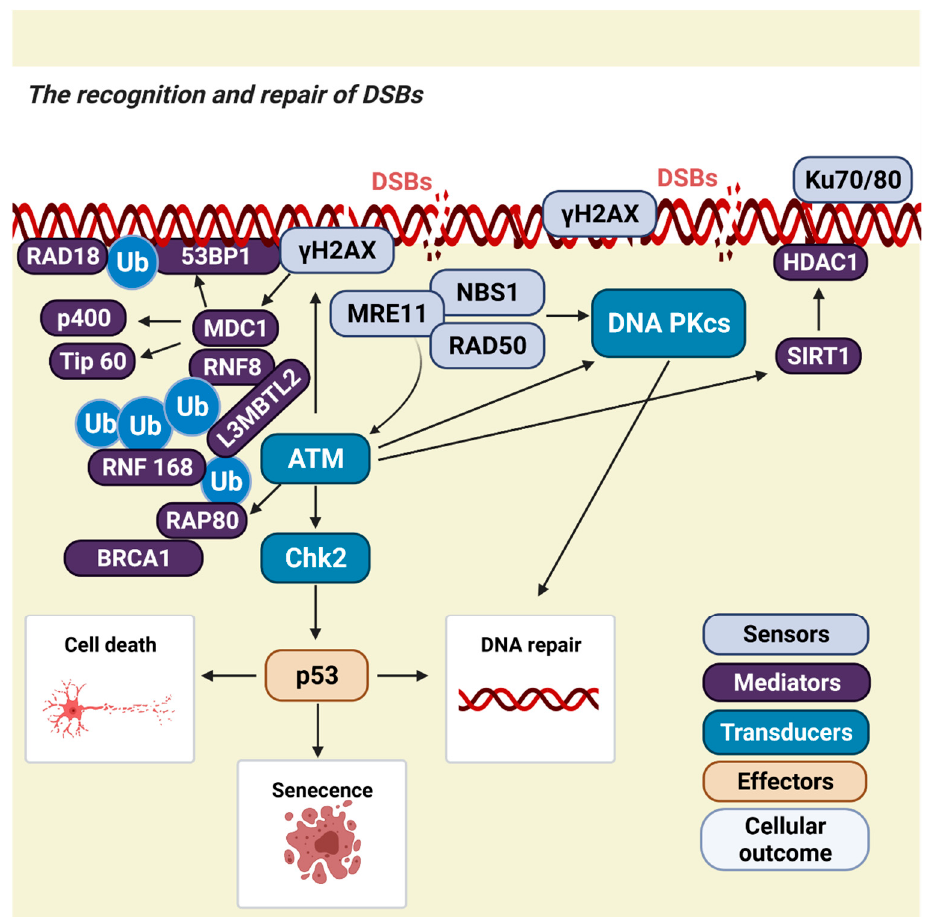
Figure 2. Schematic diagram illustrating the recognition and repair of DSBs, leading to either neuronal survival or death, and/or possibly senescence. Following DSB formation, the DDR is co-ordinated by multiple DNA damage sensors, transducers, mediators, and effectors. DSBs are detected by the MRN or Ku70/80 (sensor) complexes to recruit and activate transducer ATM or activate p53 (effector), facilitated by MDC1 and 53BP1 (mediators). There is also evidence that neurons persisting for prolonged periods after their initial attempts to re-enter the cell cycle undergo senescence